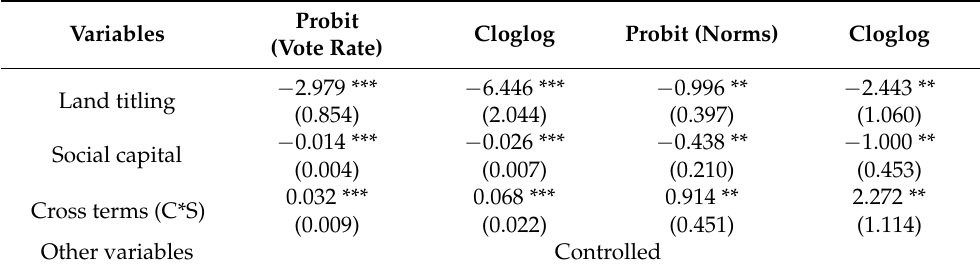
Table 5. The effect of land titling on farmland disputes with alternative social capital indicators.